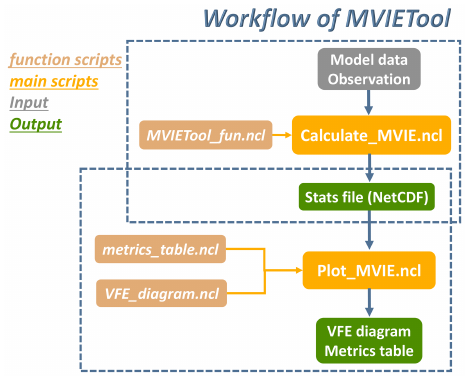
Figure 2. The structure of the MVIETool. The primary input of the workflow is model data and observation (gray) with fixed formats. Inside the dotted blue boxes are two independent runs for calcula- tion and plotting, respectively. Two main scripts (yellow) need to be invoked in sequence. The outputs (green) are the NetCDF file stor- ing performance metrics, the VFE diagram, and the metrics table.